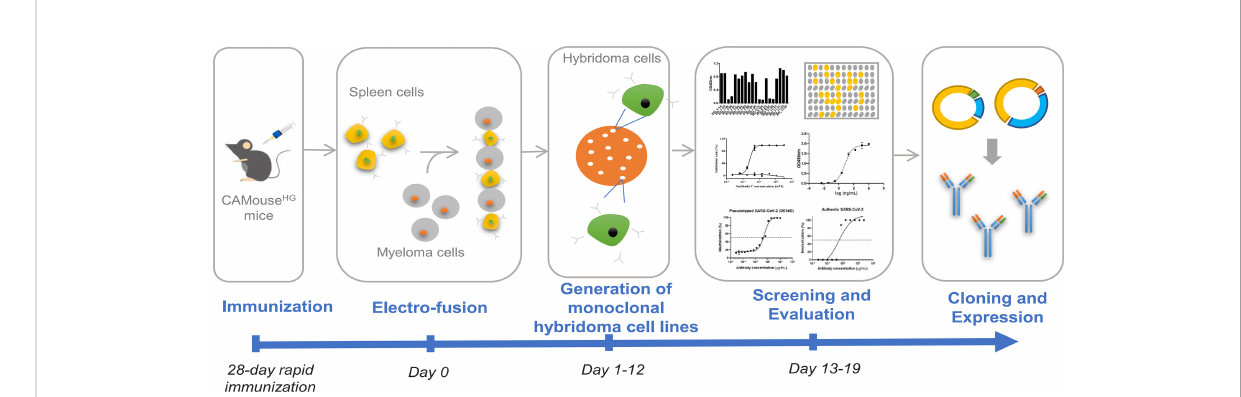
FIGURE 1 Integrated work fl ow for rapid isolation of anti-SARS-CoV-2 RBD antibodies from CAMouse HG